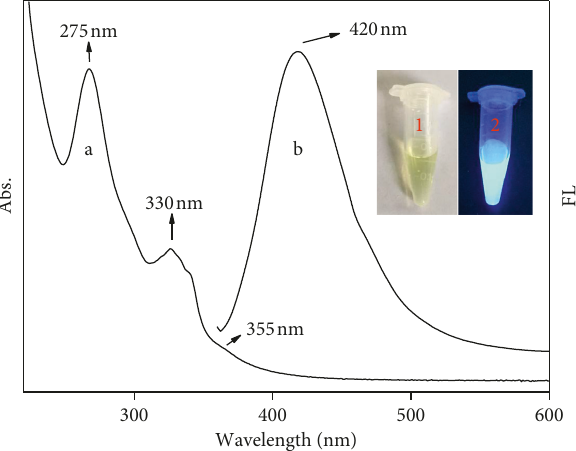
Figure 2: The UV-Vis spectra of NRPCNRs (a) and the FL spectra of NRPCNRs (b). Inset: photographs of an aqueous solution of the NRPCNRs taken under visible light (1) and 365nm UV light (2) by means of a mobile phone,